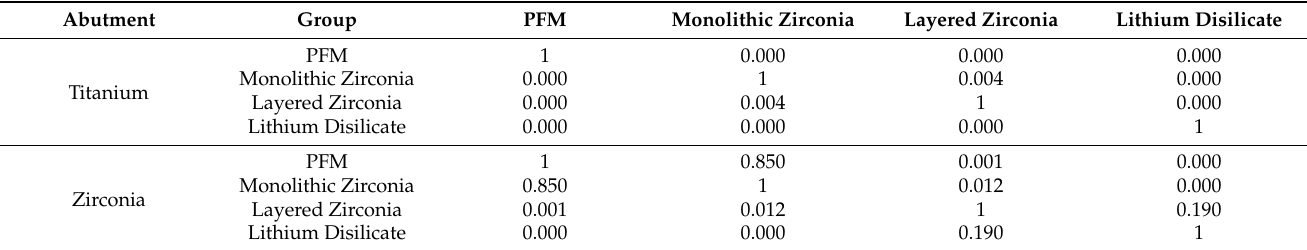
Table 3. Multiple comparisons between tested groups by post hoc Tukey’s HSD test.